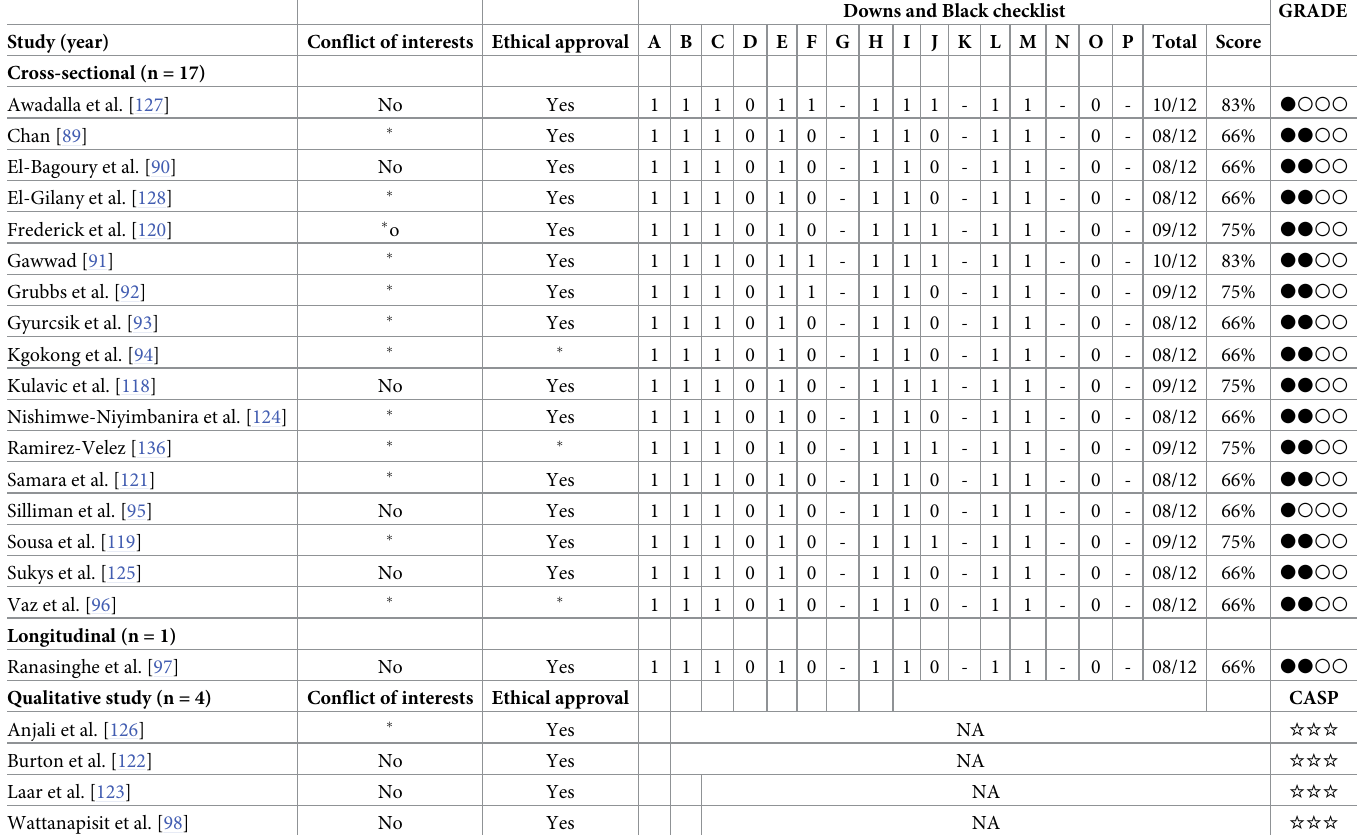
Table 6. Methodological quality and strength of evidence for studies examining barriers to physical activity in undergraduate university